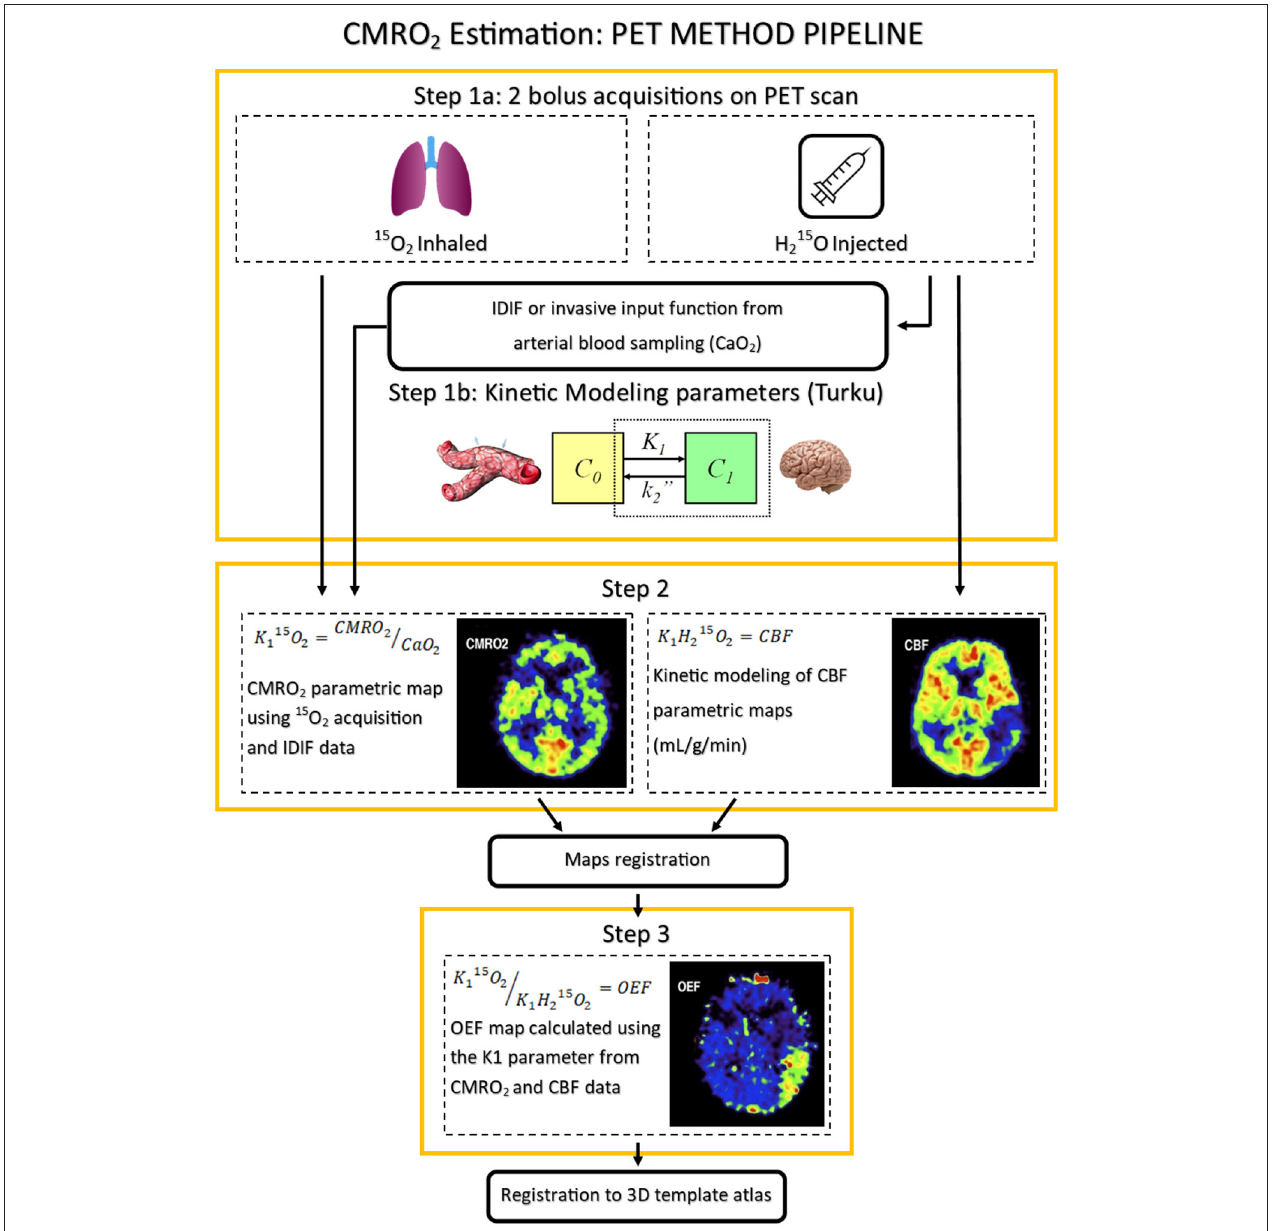
FIGURE 1 | Oxygen metabolism [ 15 O]-Positron Emission Tomography (PET) imaging pipeline. PET images published in JNM. Heiss WD. Radionuclide imaging in ischemic stroke. J Nucl Med. (2014) 55:1831–41. © SNMMI. CMRO 2 , cerebral metabolic rate of oxygen; IDIF, image-derived input function; CaO 2 , arterial blood oxygen content; VOI, volume of interest; CBF, cerebral blood flow; OEF, oxygen extraction fraction; K 1 , tracer delivery rate.